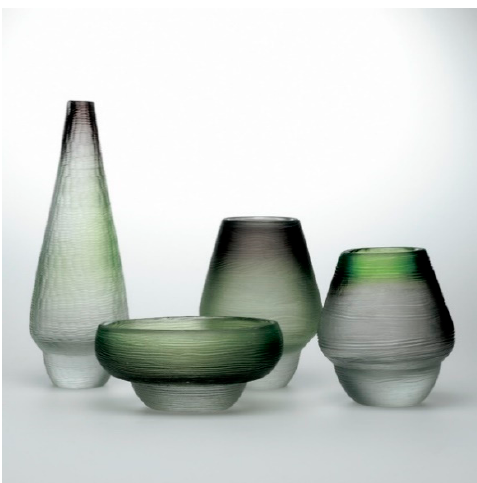
Figure 3. Maria Helena Matos, Fábrica Escola Irmãos Stephens (F.E.I.S), 1960. Photo credit: Arquivo do Museu do Vidro—Câmara Municipal da Marinha Grande.